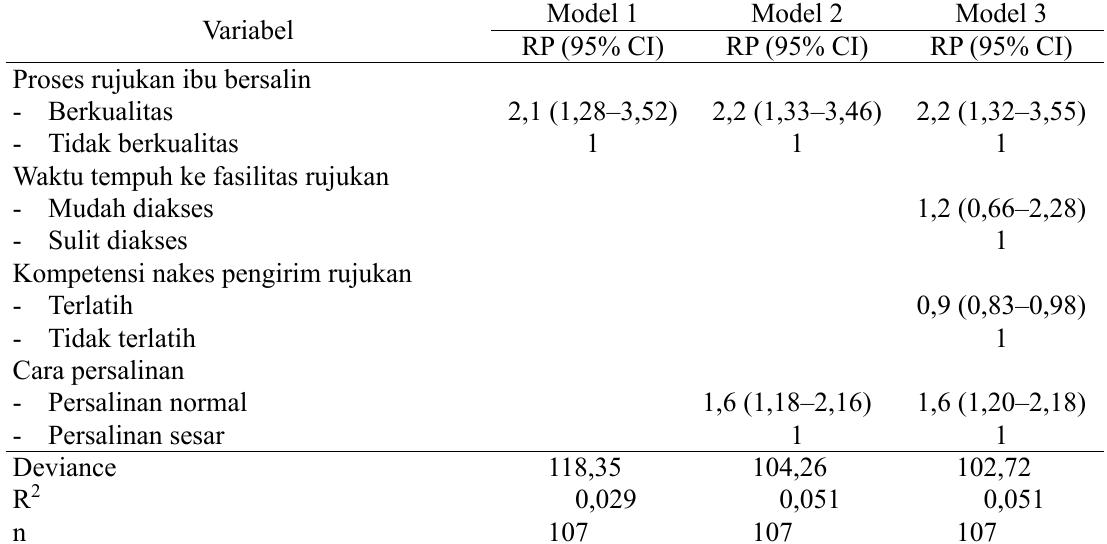
Tabel 6. Analisis model binomial regresi antara morbiditas ibu dengan proses rujukan ibu